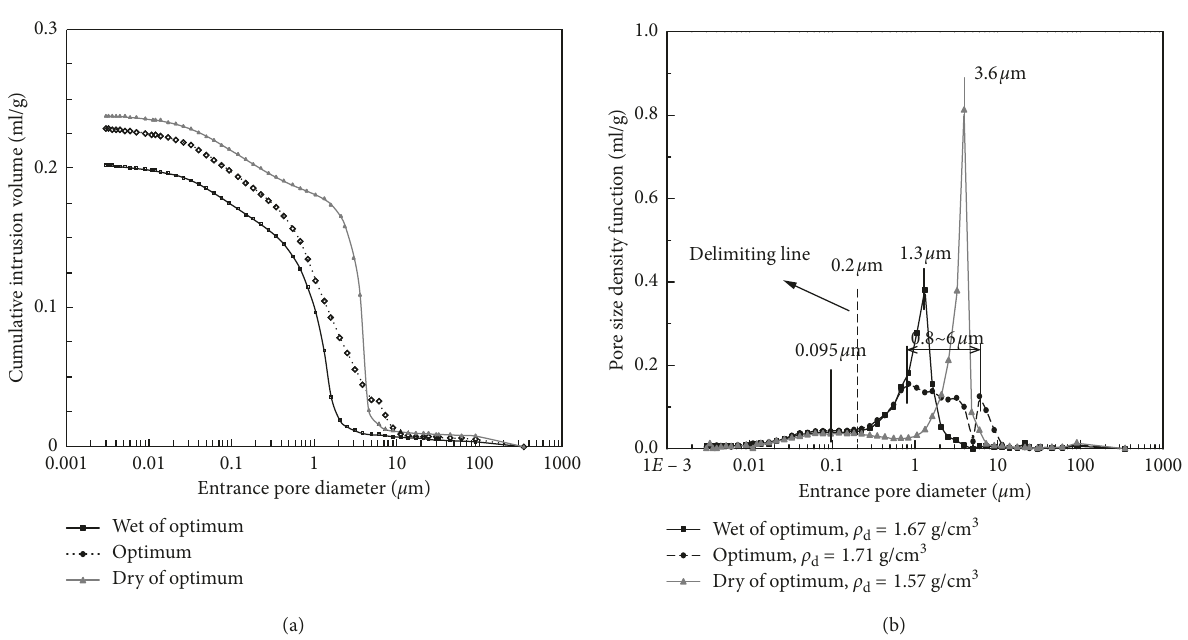
Figure 4: MIP test results on three compacted loess specimens. (a) Cumulative intrusion curve. (b) Pore size density